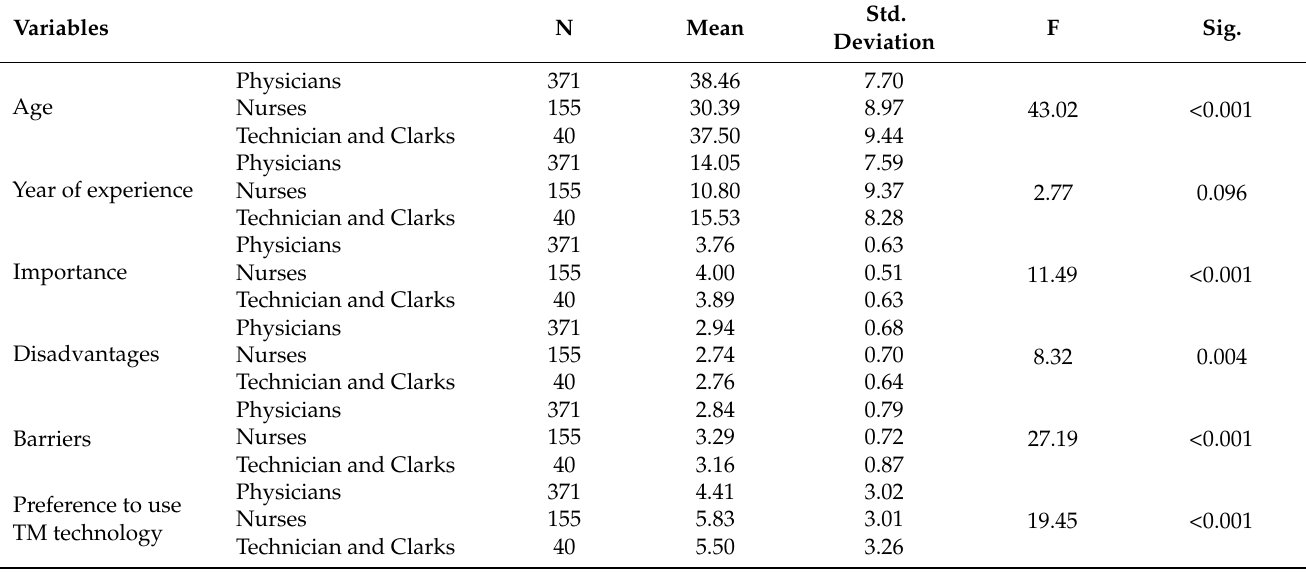
Table 5. Comparison of PTIDB domains according to the healthcare professional speciality (n =